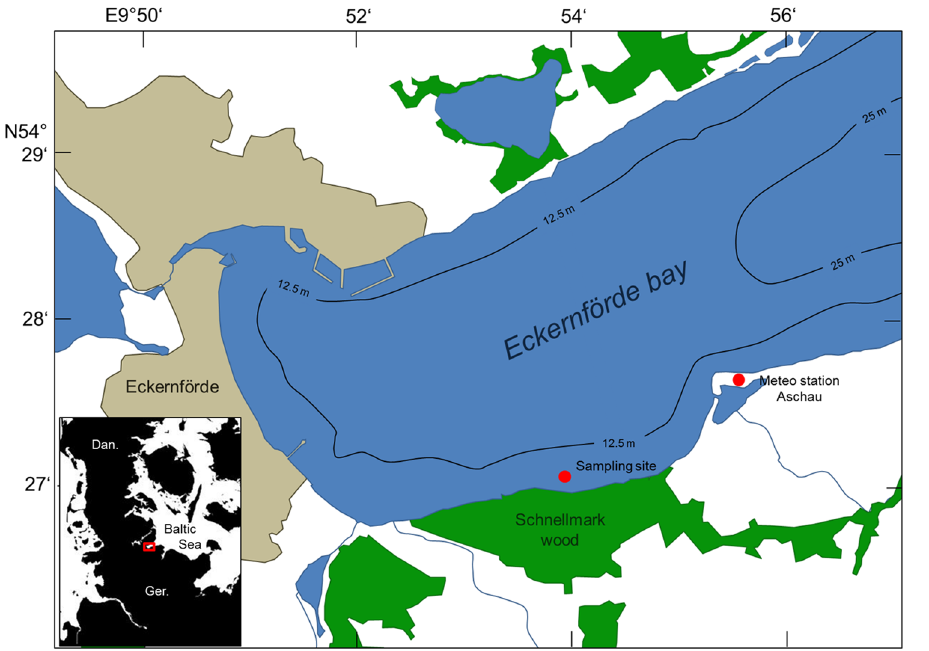
Figure 1. Study site. Map of the inner Eckernfo¨rde Bay indicating the locations of the survey site and the meteorological station, urban area (brown) and forests area (green).